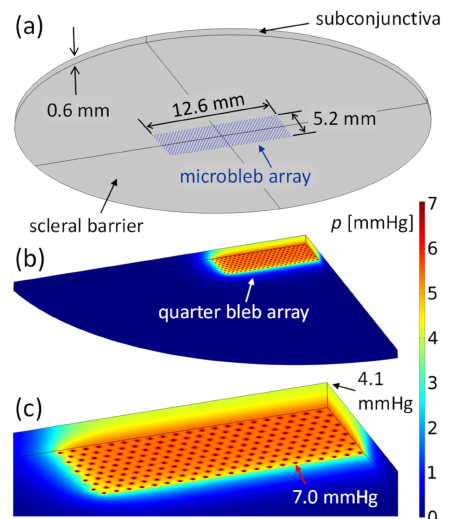
Figure 6. ( a ) Microbleb array of 12.6 × 5.2 mm 2 of the current stent meshwork. The microblebs lie on the scleral barrier and are spaced 300 µ m apart. All blebs have a radius of r b = 30 µ m. AH flows from the bleb surfaces into the 0.6 mm thick subconjunctiva. ( b , c ) Drainage pressure field in the subconjunctival tissue determined by COMSOL simulation. The total flow rate of the bleb array is 1.7 µ L . Figure 6b shows a quarter of the simulation domain. Figure 6c is an enlarged view of 6b. The min pressure inside the blebs is 7 mmHg and reaches 4.1 mmHg at the surface of the subconjunctiva. The pressure decreases rapidly in the plane of the array within the characteristic length 1/